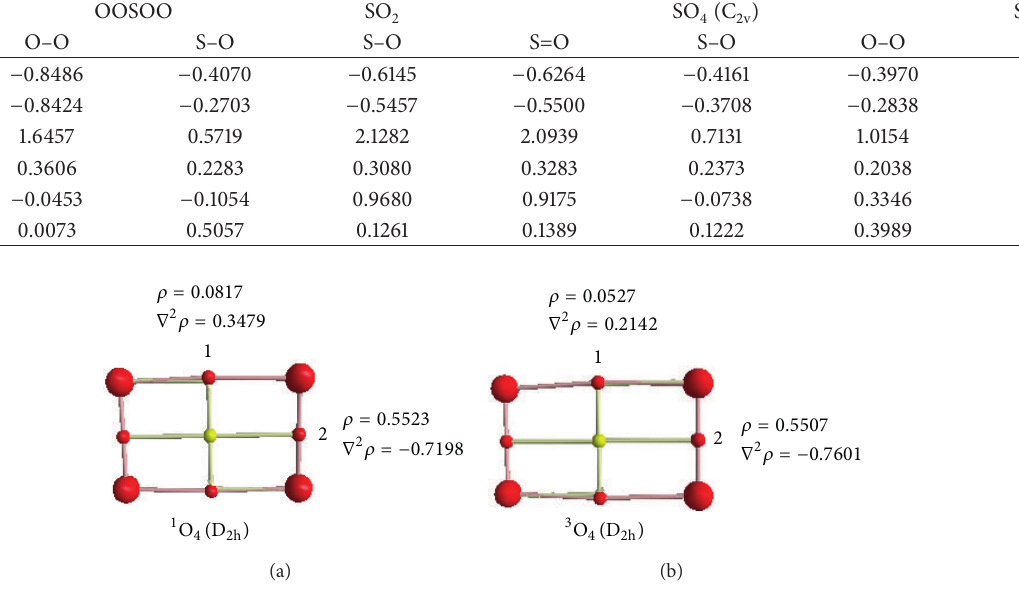
Figure 3: The values of the AIM theory topological parameters for bonds of tetraoxygen on the singlet and triplet PESs.